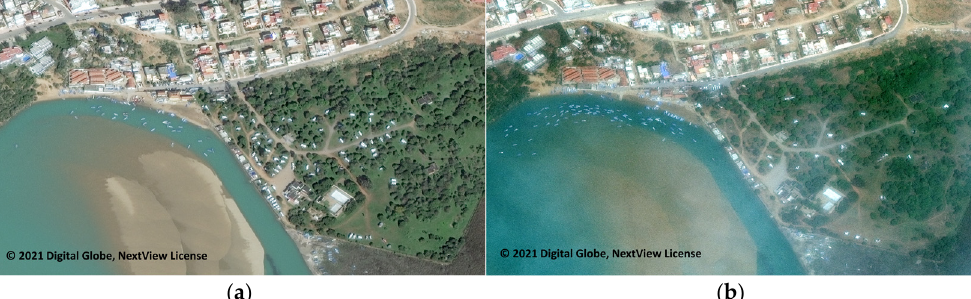
Figure 5. Decrease in tourism activity can be seen in the decreased numbers of vehicles in the parking area at Merja Zerga, a Ramsar Site. ( a ) Before the pandemic in April 2019; ( b ) during the Ramsar Site. ( a ) Before the pandemic in April 2019; ( b ) during the pandemic in April 2020. (Image© 2021 Digital Globe, pandemic in April 2020. (Image© 2021 Digital Globe, NextView License). NextView